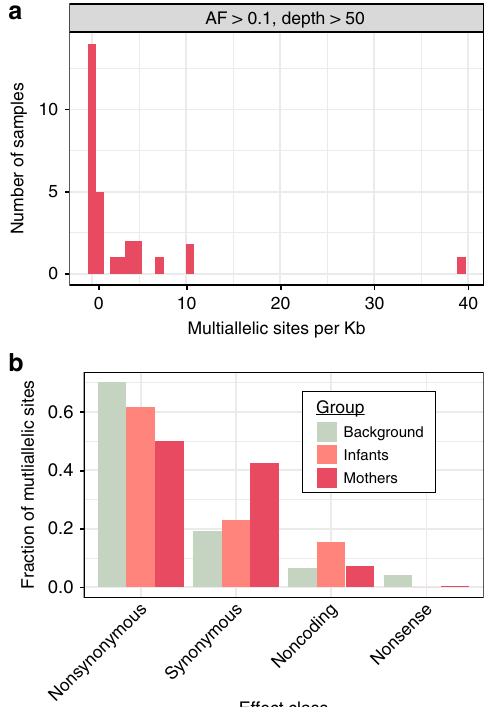
Fig. 3 Predicted effects of multiallelic sites differ in the p-crAssphage population of mothers and infants. a Distribution of multiallelic sites per kilobase in samples from mothers. b Distribution of predicted effects of multiallelic sites from mother and infant samples, compared to a background distribution of equal probability of each DNA change at each position in the p-crAssphage reference